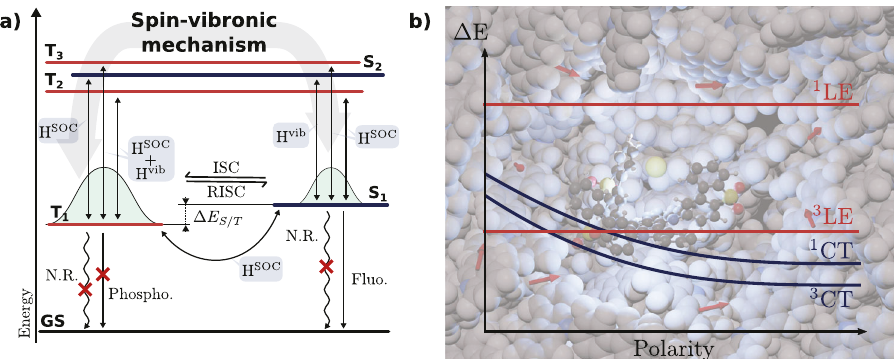
Fig. 1 Spin-vibronic mechanism. a Schematic representation of the TADF mechanism. H SOC is the spin-orbit coupling. H vib is the vibronic coupling. N.R. Non-Radiative decay pathways, Fluo. Fluorescence, Phospho. Phosphorescence. b Effect of the polarity of the environment on the energy of excited state involved in the TADF process. The locally excited (LE), e.g. ππ * , state is much less in fl uenced by host polarity than the charge transfer (CT) states which have a large dipole